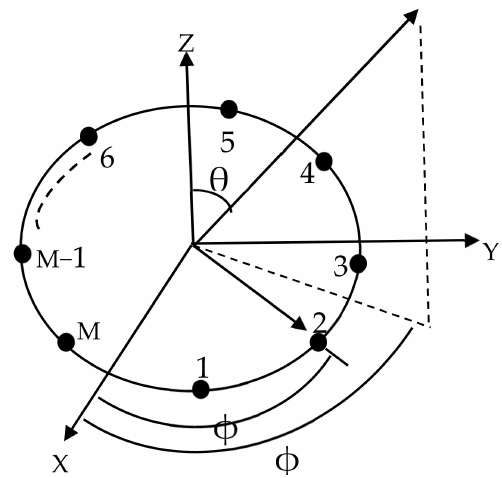
Figure 1. Asymmetric N isotropic circular antenna array